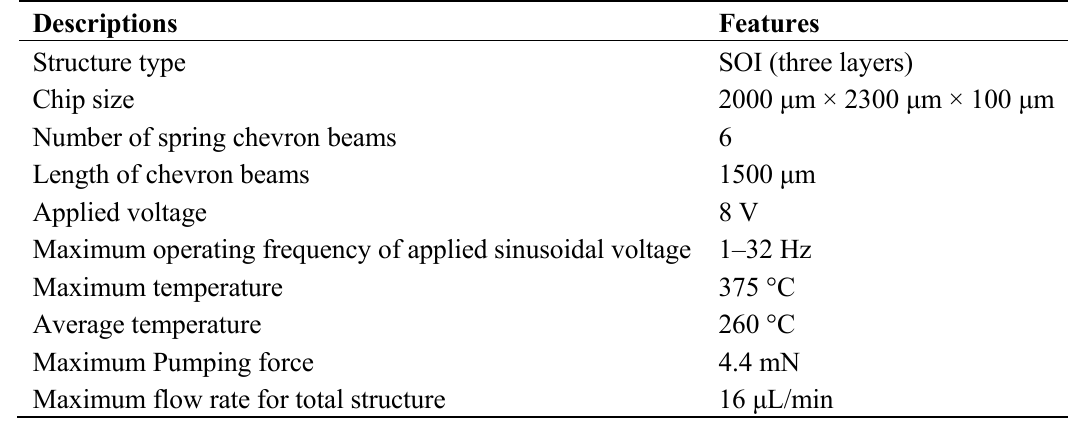
Table 5. Features of the proposed micropump structure [28].